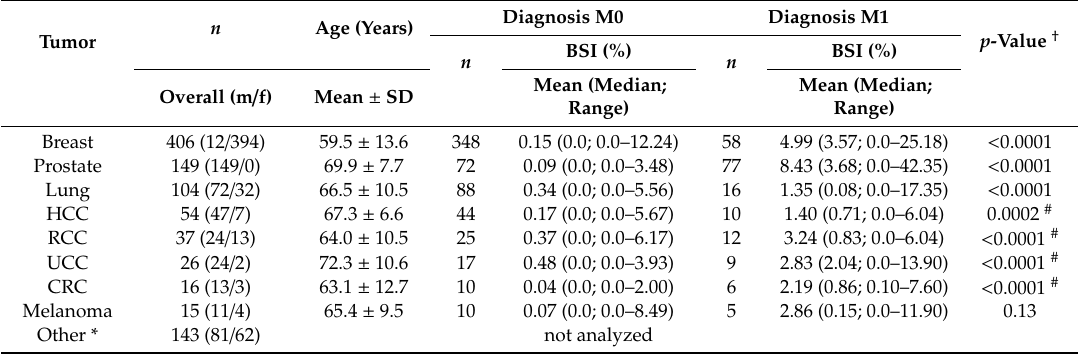
Table 1. BSI values determined in di ff erent tumor entities for patients found to have no bone metastases (M0) or having bone metastases (M1) according to clinical